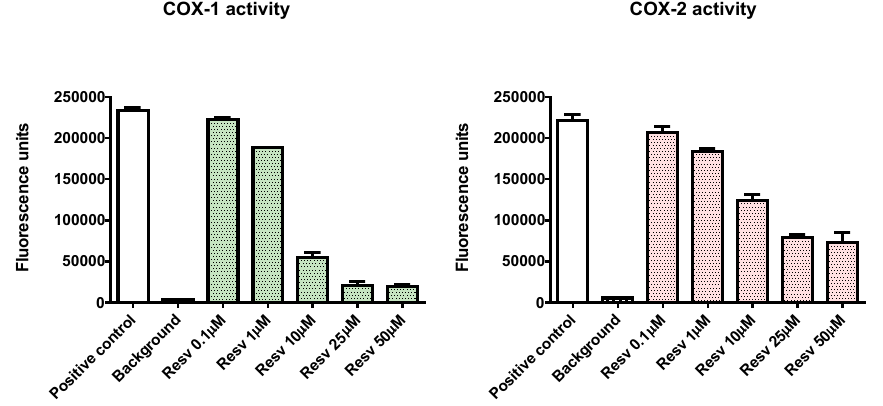
Figure 1. Inhibitory effects of Resveratrol on COX1 and COX2 activities, two enzymes involved in the synthesis of pro-inflammatory leukotrienes. Resv, resveratrol; COX-1 and COX-2, cyclo-oxygenases 1 and 2 [27].